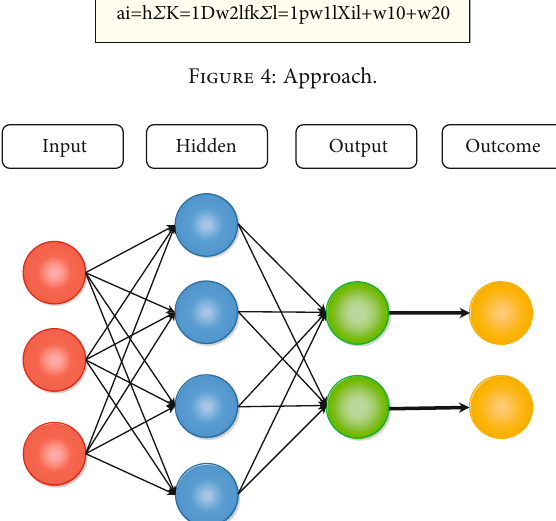
Figure 5: Neural network